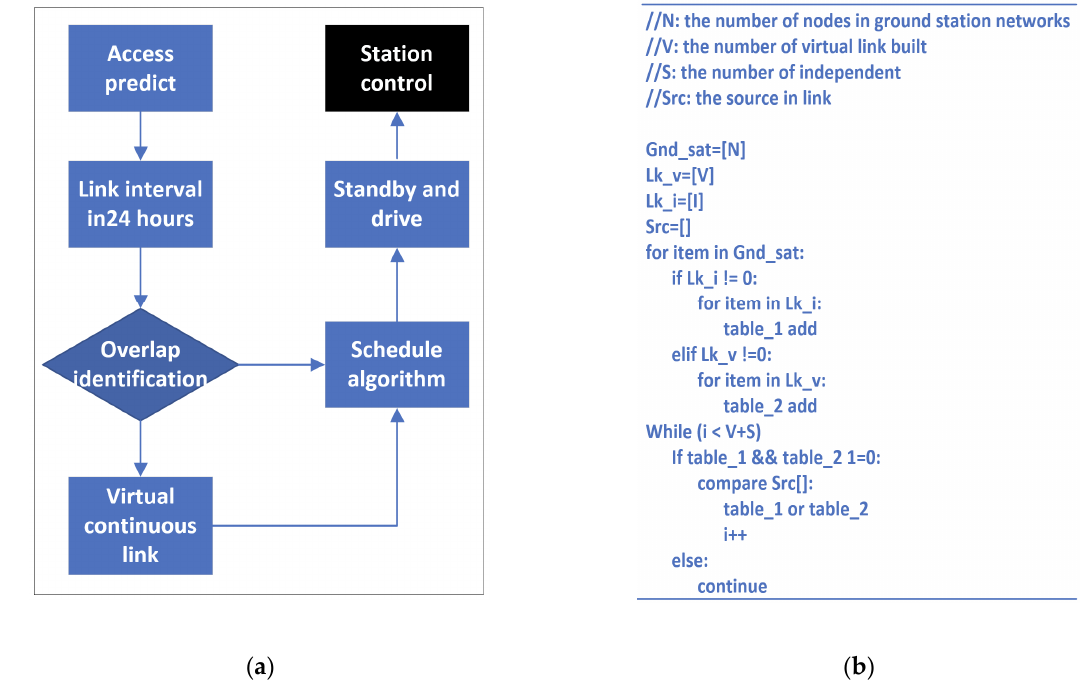
Figure 10. ( a ) Assignment flow; ( b ) pseudocode of schedule algorithm. Table 4. Warm-up